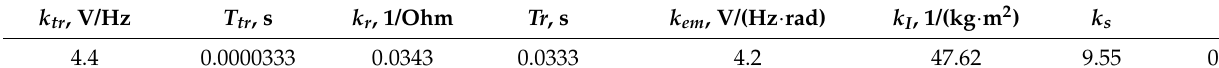
Table 1. Numerical values of parameters of transfer functions of structural IM model (Figure 5).